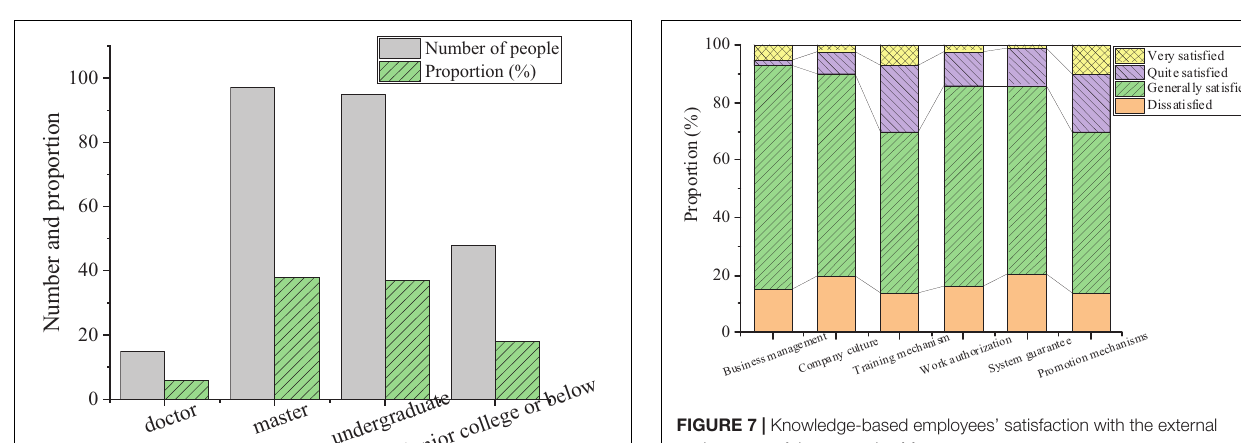
FIGURE 7 | Knowledge-based employees’ satisfaction with the external environment of the enterprise